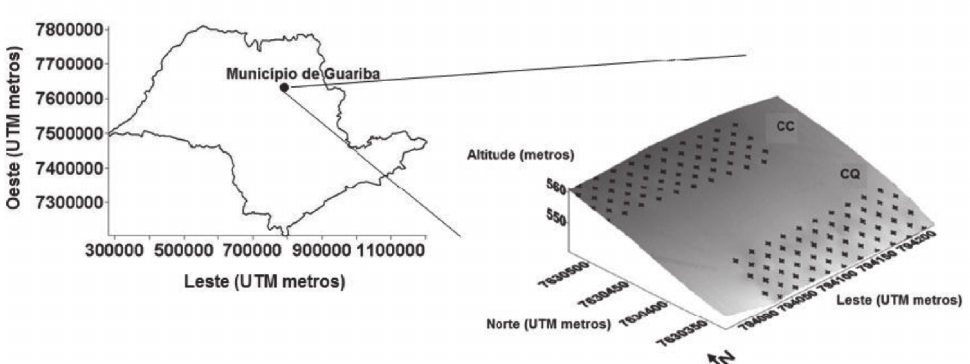
Figura 1. Localização da área e do modelo digital de elevação (MDE); área com sistema de colheita manual com queima (cana queimada - CQ); e sistema de colheita mecanizada sem queima (cana crua -